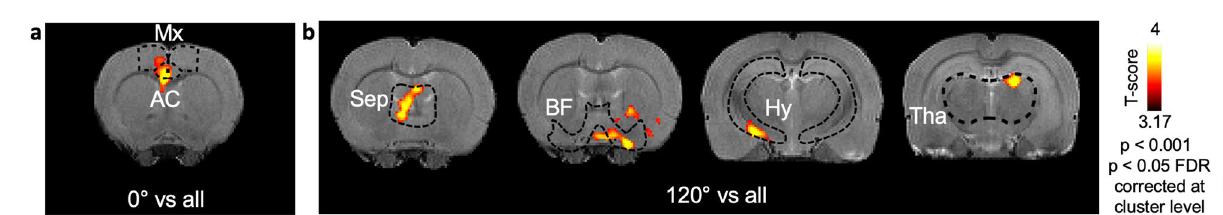
Figure 4. Contrast analysis of OS-ESCS. Contrast t-maps showing the significant clusters obtained by the analyses 0° vs all ( a ) and 120° vs all ( b ). Only contrasts providing significant results are shown. The t-maps have been produced with a statistical threshold of p < 0.001 at voxel level (n = 11). The cluster survived the statistical threshold of p < 0.05 FDR corrected. Mx motor cortex (including primary and secondary motor cortices), AC anterior cingulate, BF basal forebrain regions, Hy hippocampus, Sep septal regions, Tha activations were consistent among single subjects, irrespective of S1 vs L2 spinal segment electrode implanta- tions (Supplementary Figures 3 and 4), whereas the spread and angle dependence of the activation patterns was variable among subjects. The observed pattern of activation demonstrates a consistent involvement of brain areas responsible for direct or indirect transmission of sensory and motor information from the spinal cord to the brain network via the thalamus and related cortices. Strong orientation selectivity occurred in the cingulate and motor cortices, brain areas highly connected or belonging to the motor network 25 , as revealed by voxel- wise contrast analysis between 0° and all other angles (0° vs all contrast). Strong orientation selectivity was also observed when analyzing the contrast between 120° vs all other angles in areas within the basal forebrain and septal regions, the thalamus and the hippocampus. These two directions (0° and 120°) have an important geo- metrical valence since 0° is the direction parallel to the spinal cord whereas 120° is the closest direction to the dorsal roots, the first hub of the sensory pathway. ESCS and brain fMRI studies have been done in humans 5,26–29 . In such earlier studies, negative activations of the thalamus, cingulate cortex and insula were seen in failed back surgery patients 28 , but also negative and posi- tive activations have been reported in the somatosensory cortex while having negative activation in the primary motor cortex 5 . ESCS and brain fMRI studies have been conducted also in rats 30,31 . Upon stimulation of the dorsal root ganglion of a rat, nearly no brain fMRI response was observed with a therapeutic level stimulus, although at higher stimulus positive activation of the thalamus and negative activation of the caudate and putamen were